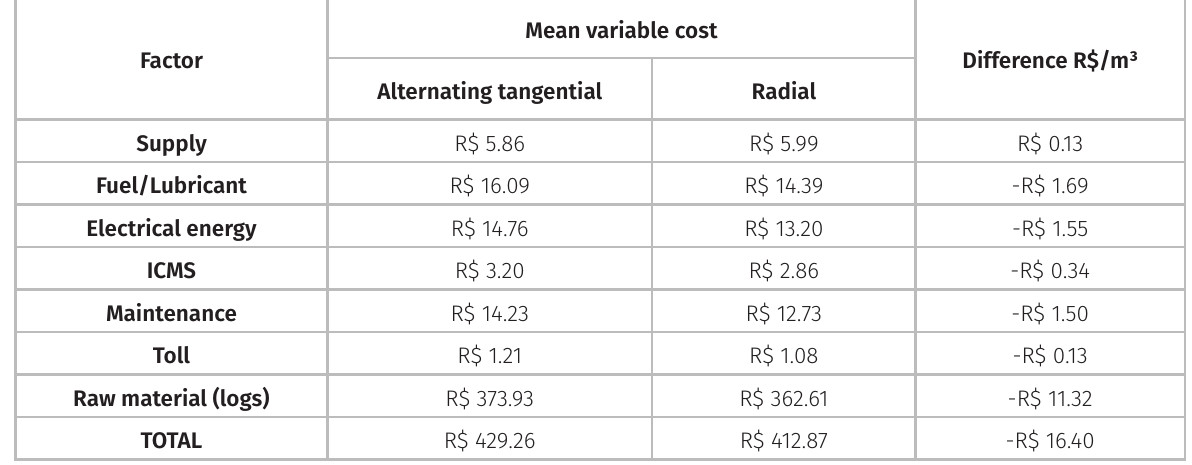
Table V. Percentage of mean variable costs for the alternating sawing pattern and radial sawing pattern.